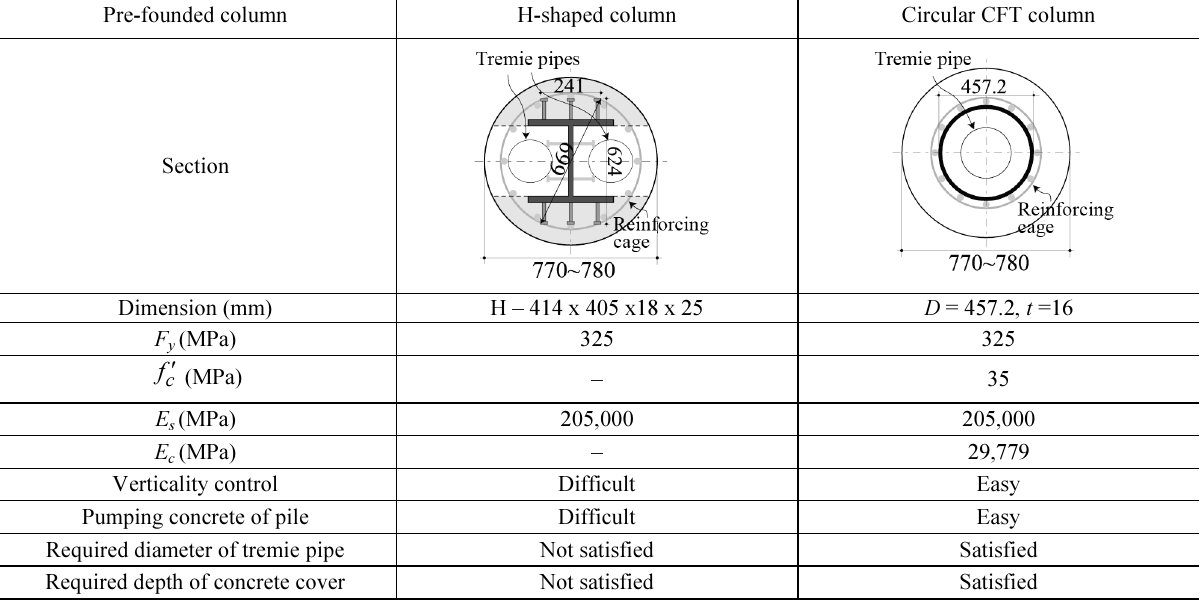
Table 2. Comparison between H-sections and circular CFTs as pre-founded columns Pre-founded column H-shaped column Circular CFT